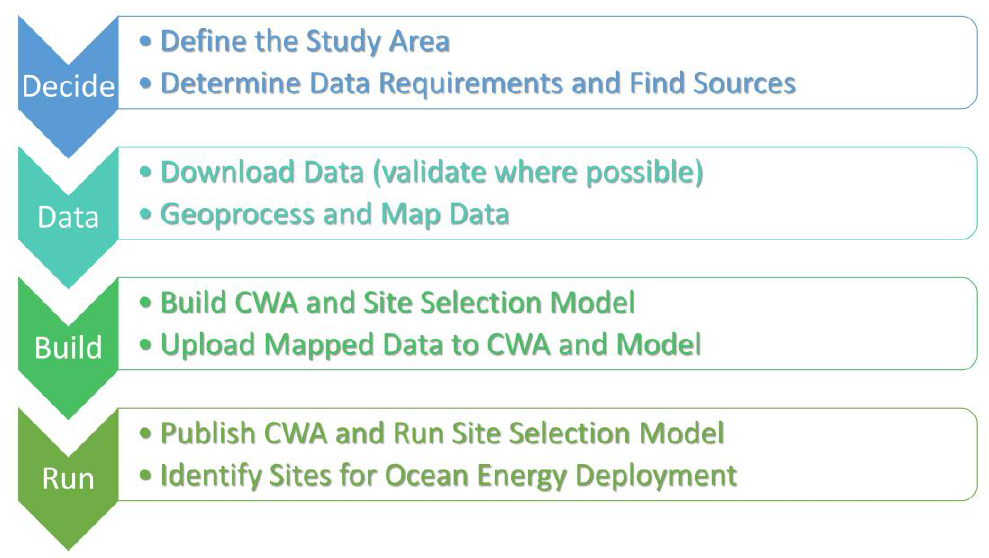
Figure 1. General flow of steps taken in the methodology of this study.